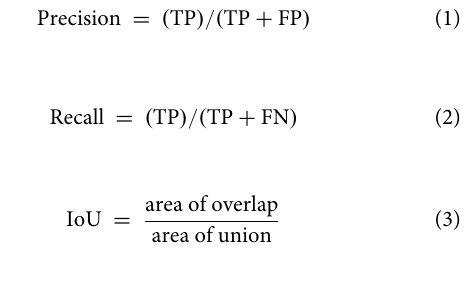
TABLE 2 The environment configuration used in the experiment. Environment